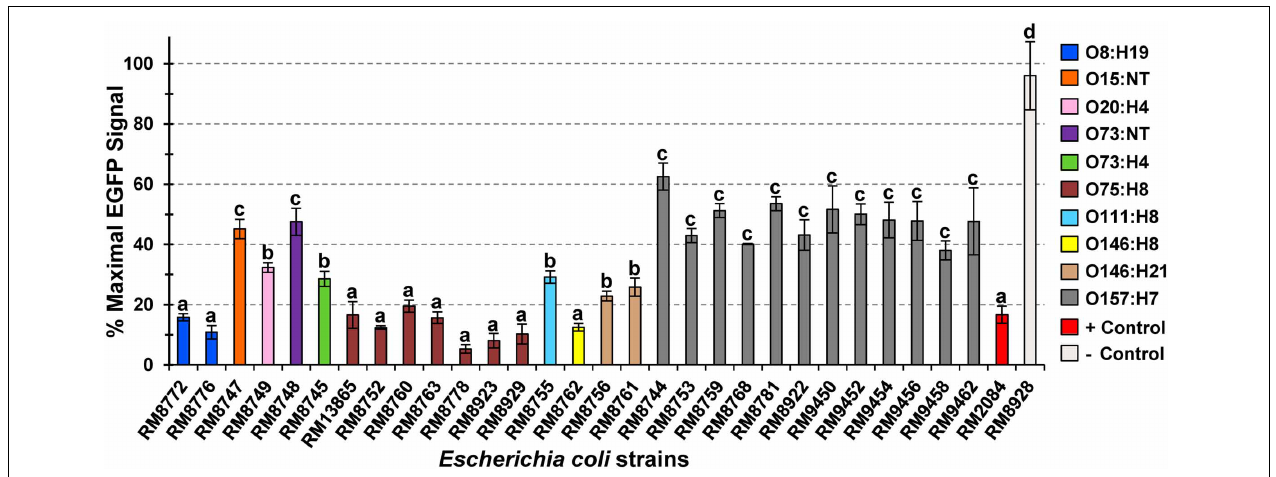
FIGURE 1 | Effect of Escherichia coli O157 and non-O157 culture supernatants on Vero-d2EGFP fluorescence. Vero-d2EGFP cells were incubated in Ham’s F-12 complete medium containing tenfold dilutions of cell-free culture supernatants from the tested Escherichia coli O157 and non-O157 strains ( Table 1 ). Cell-free culture supernatants from the Stx-producing E. coli O157:H7 strain RM2084 and from the non-Stx